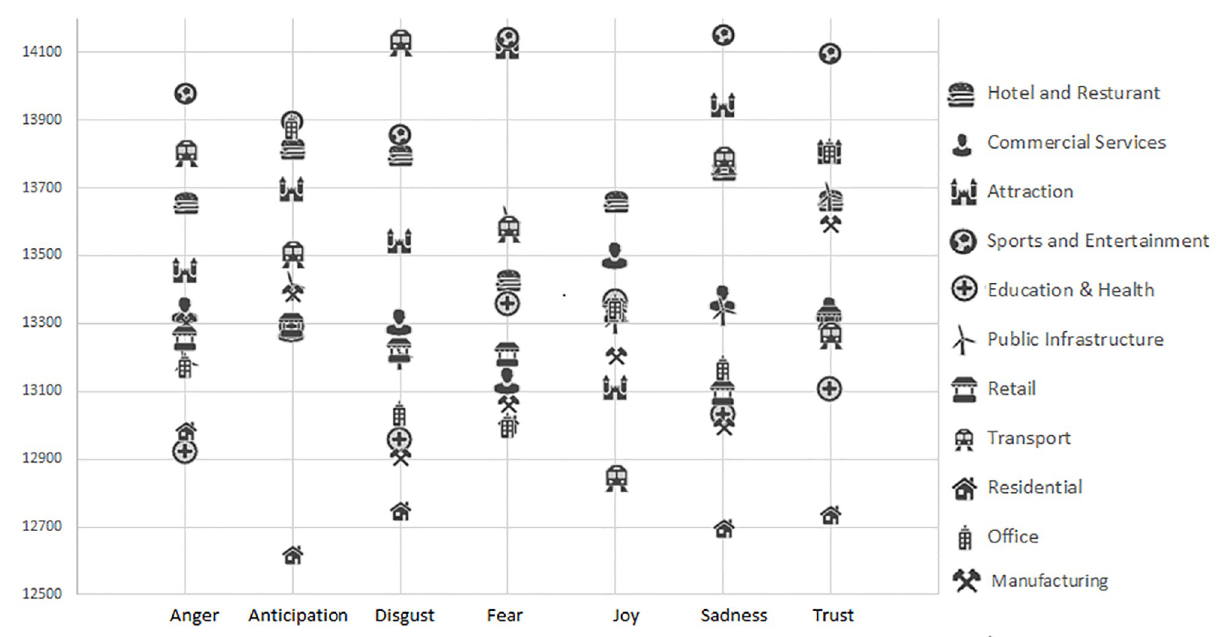
Fig 8. The emotions displayed for different location categories in London (based on the mean rank. A higher rank denotes a higher level of emotion).